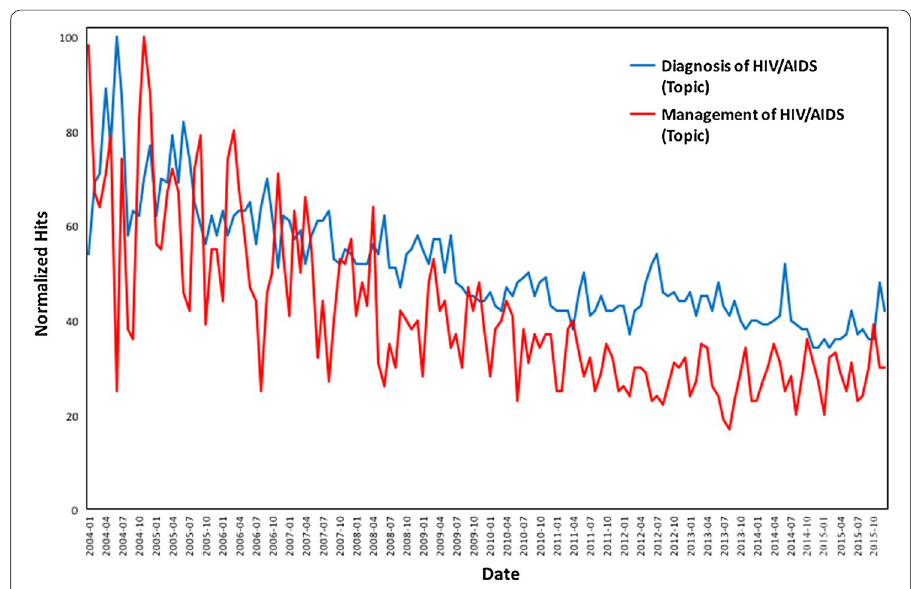
Fig. 2 Monthly normalized Google Trends’ Data for ‘Diagnosis of HIV/AIDS (Topic)’ and ‘Management of HIV/ AIDS (Topic)’ from January 2004 to December